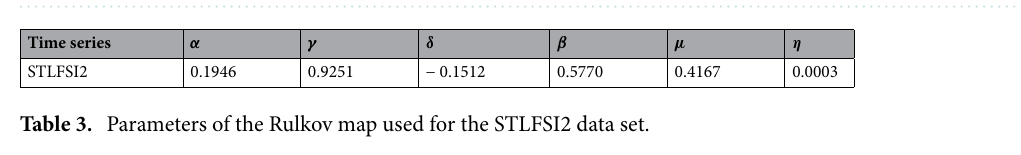
Figure 4. ( a ) Rulkov variable ˆ x (solid blue line) and STLFSI2’s immediate value x , dashed red line); ( b ) Rulkov variable ˆ y (solid blue line) and STLFSI2’s long term value y (approximated the moving average over m = 52 data points of x , dashed red line). ( c ) Difference between Rulkov ˆ x -value and STLFSI2’s value x ; ( d ) Difference between Rulkov’s ˆ y and STLFSI2’s long term value y . ( e ) Difference between ˆ x -variable of the calibrated ARIMA-GARCH ∗ and the immediate value of STLFSI2 x ; ( f ) Difference between the ˆ y -variable of the calibrated ARIMA-GARCH ∗ and STLFSI2’s long term value y .